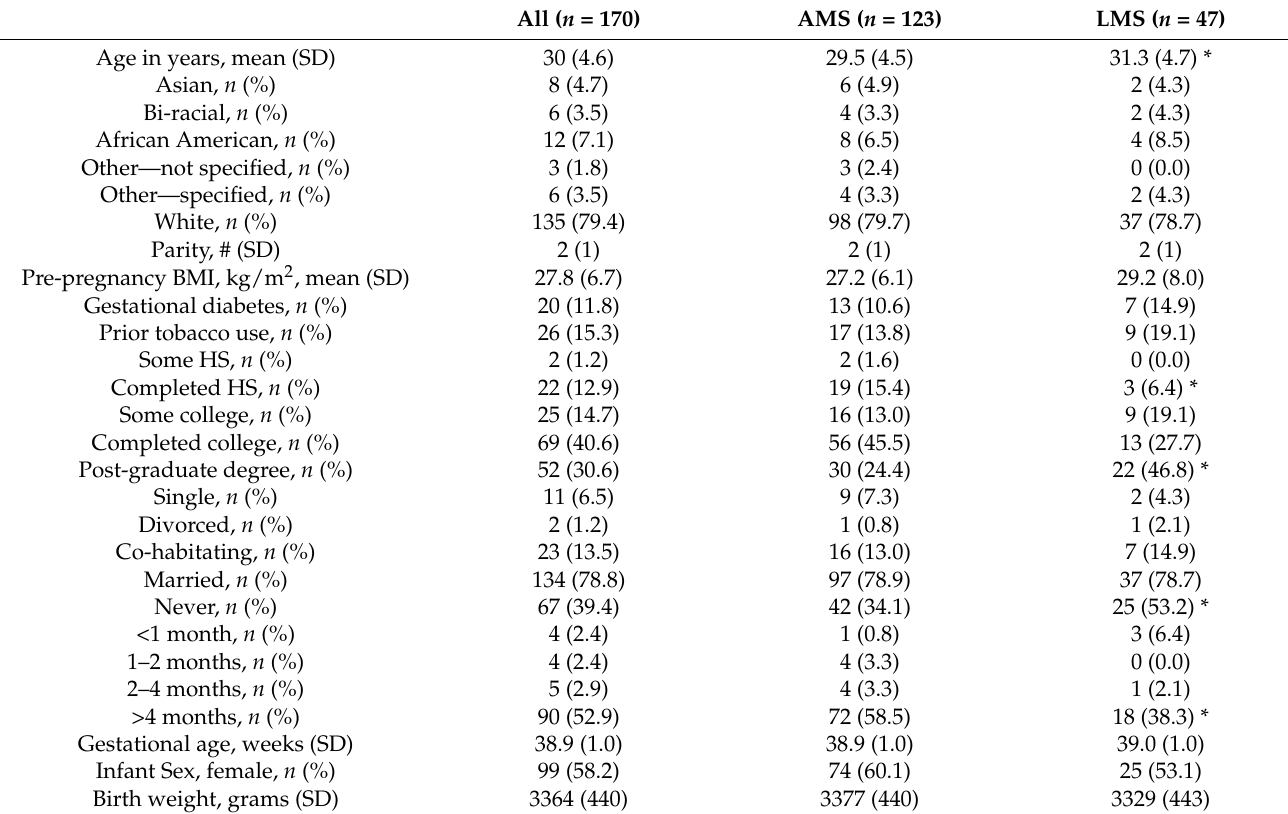
Table 1. Participant